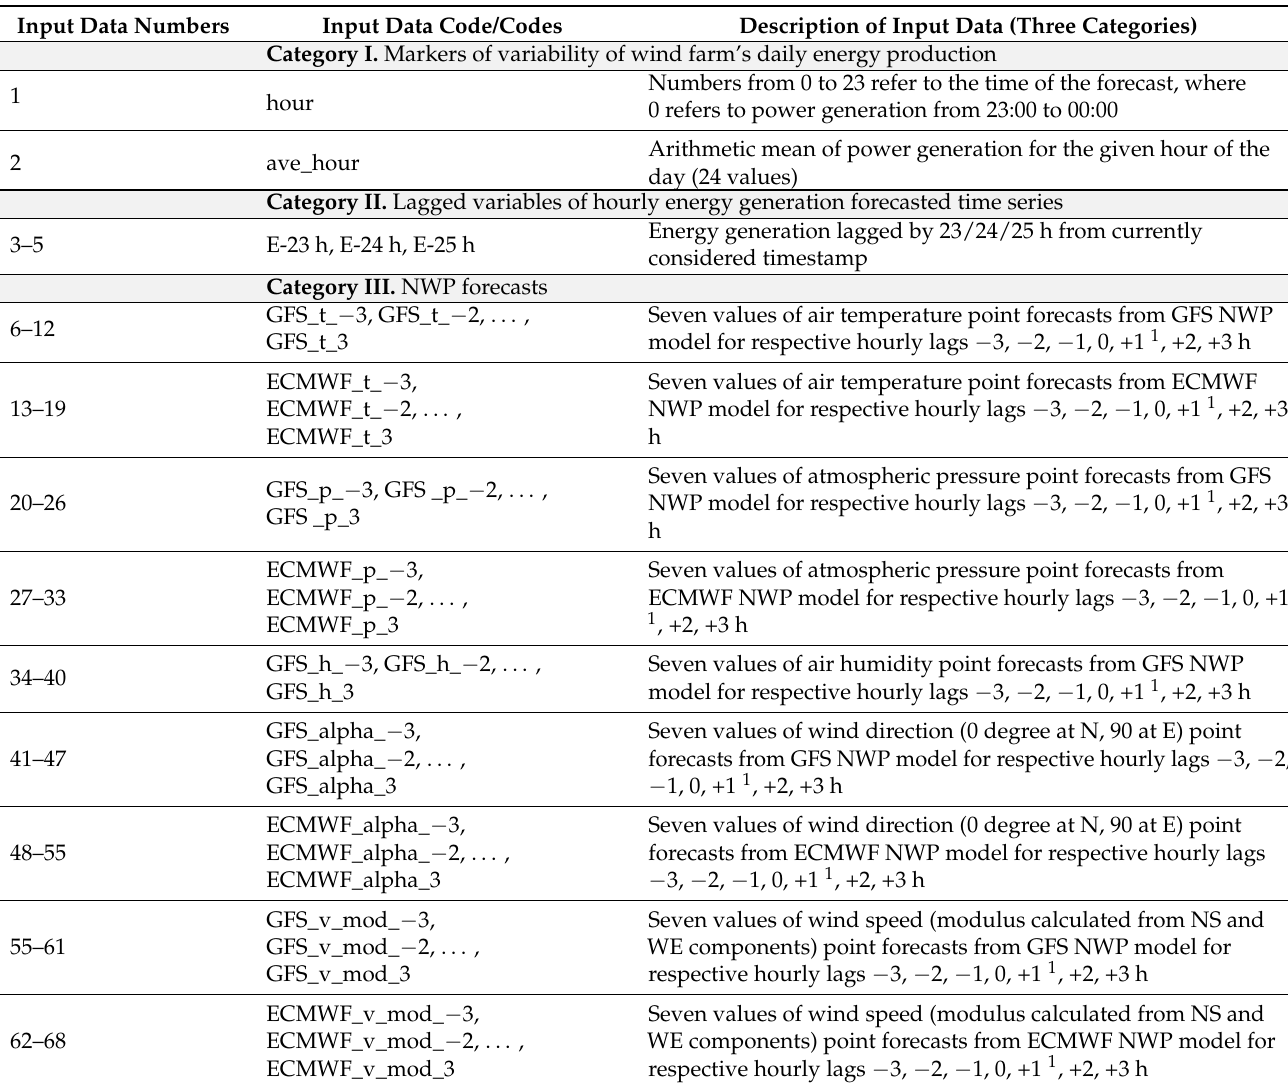
Table 2. Description of available basic input variables for forecasting models.